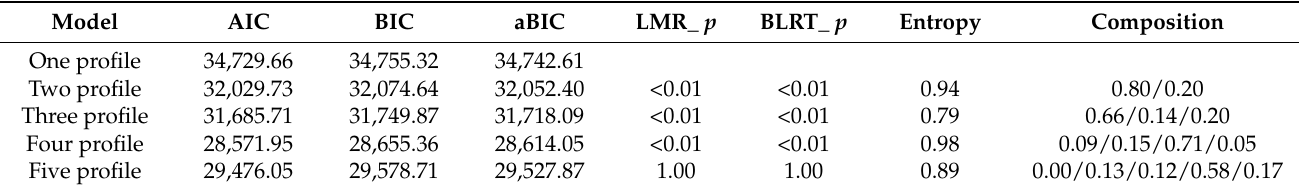
Table 2. Results of statistical fit indices of latent profile analysis models.